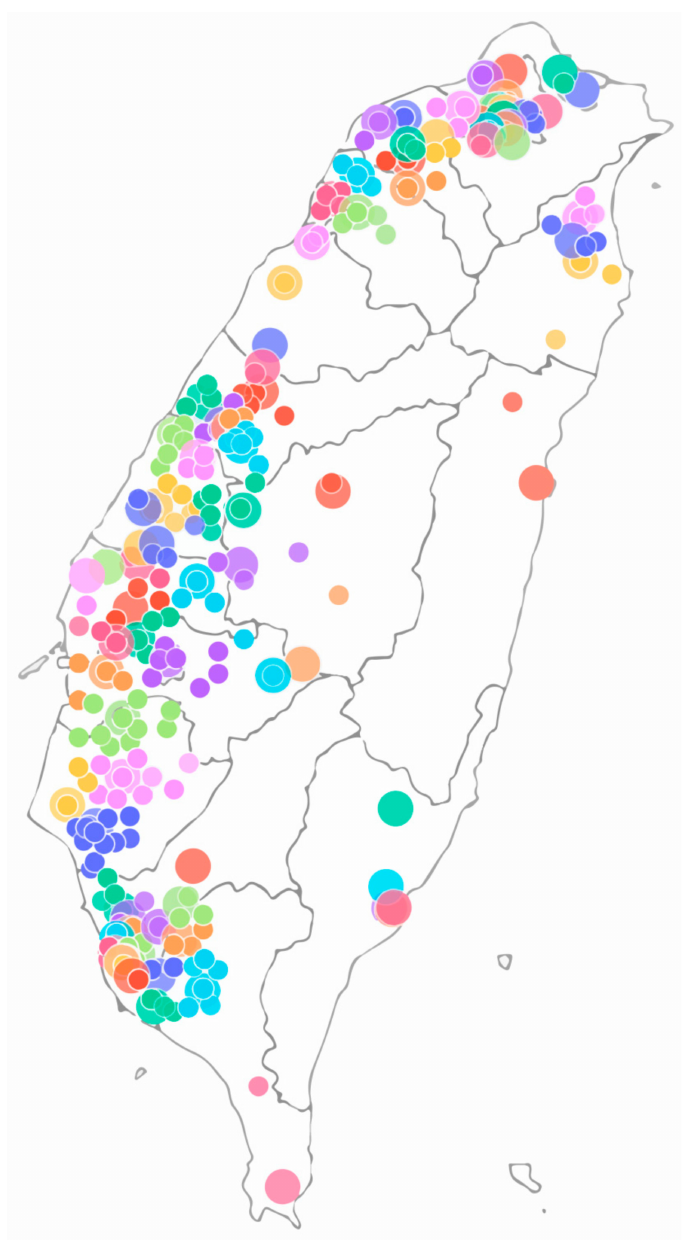
Figure 1. Example of nearest neighbor interpolation: Big circles stand for monitoring station, small ones for